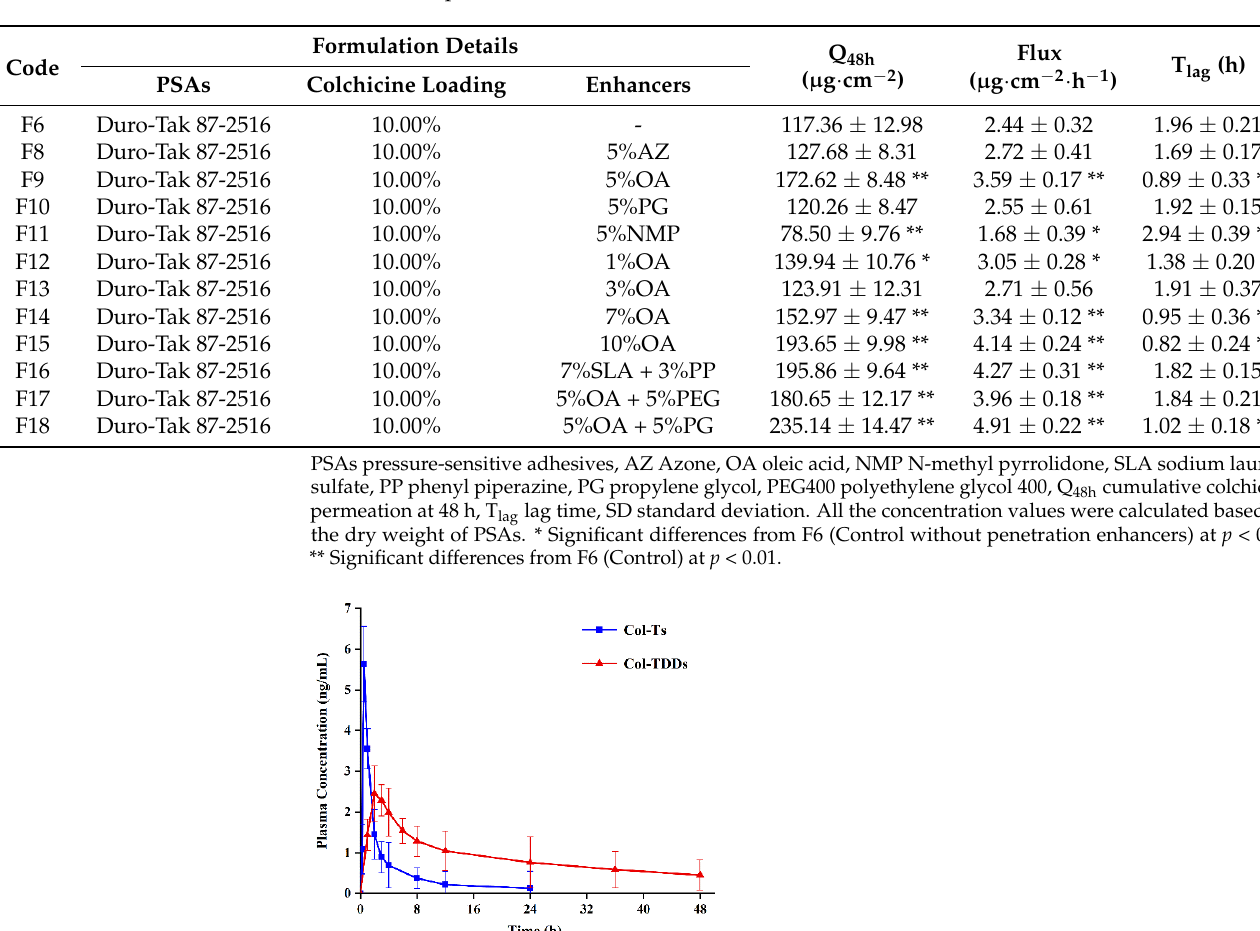
Table 4. In vitro pig skin permeation parameters of colchicine from patches containing 10% colchicine and different permeation enhancers in Duro-Tak 87-2516 (mean ± SD, n = 6).